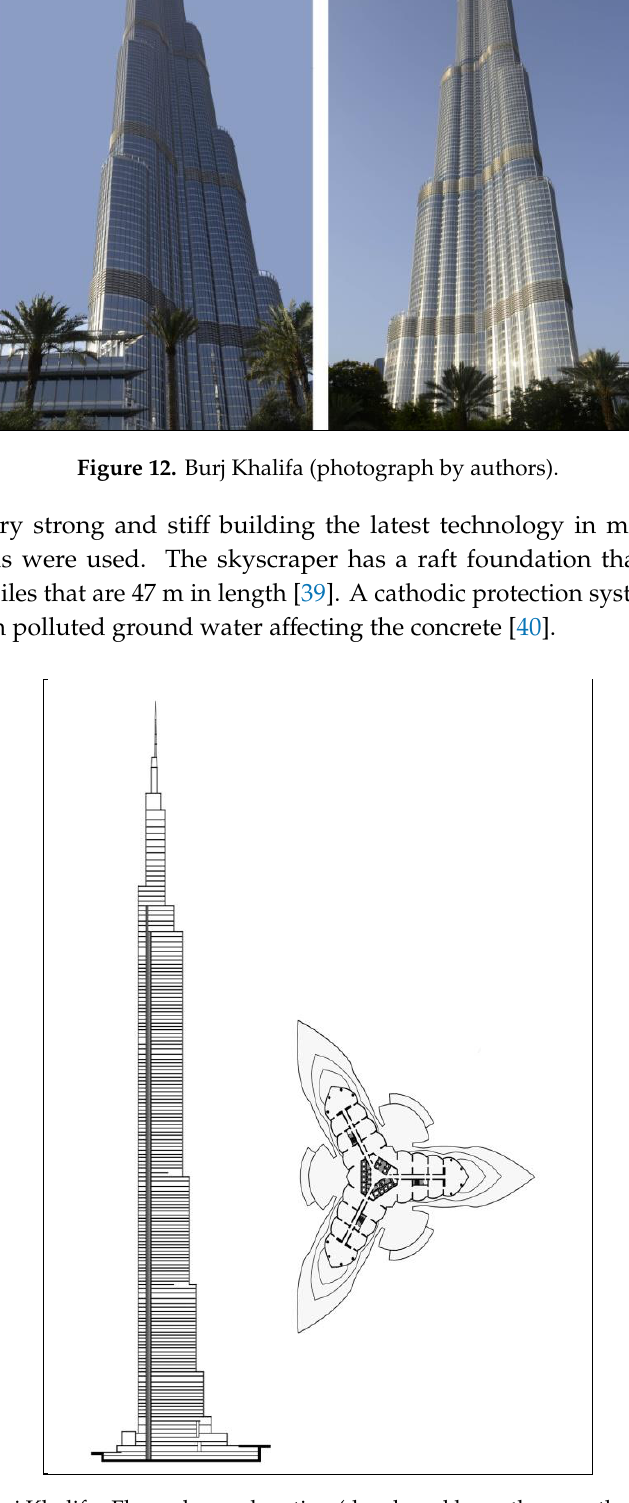
Figure 13. Burj Khalifa: Floor plan and section (developed by authors on the basis of [41]).